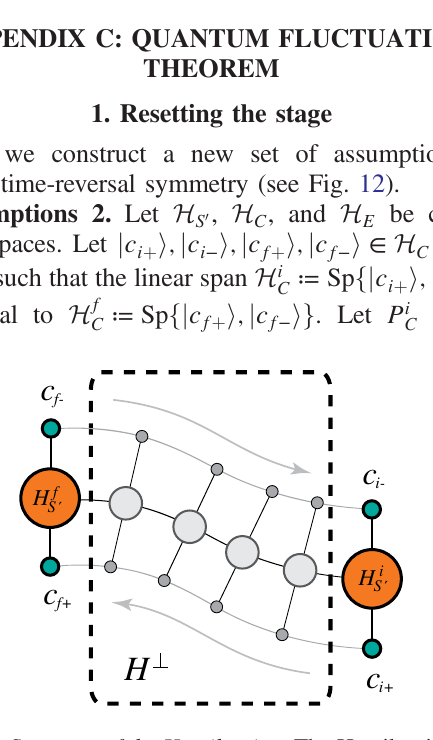
FIG. 12. Structure of the Hamiltonian. The Hamiltonian S 0 C is ⊗ P i ⊗ P f H i of the form H þ H f þ H ⊥ . Hence, S 0 C ¼ C C S 0 S 0 whether the state of the control is in subspace H i onto which C P i projects or in H f onto which P f projects, this determines the C C C Hamiltonian of S 0 . The Hamiltonian H ⊥ corresponds to any possible intermediate stages. The initial control space H i is C and j c , which are the time reversals spanned by two states j c i þ i i − i of each other. Analogously, the final control space H f is spanned C and j c . The global evolution V is such that it brings by j c f þ i f − i control state j c into j c , while it brings j c into j c , thus i þ i f þ i f − i i − i implementing both the forward and the reverse